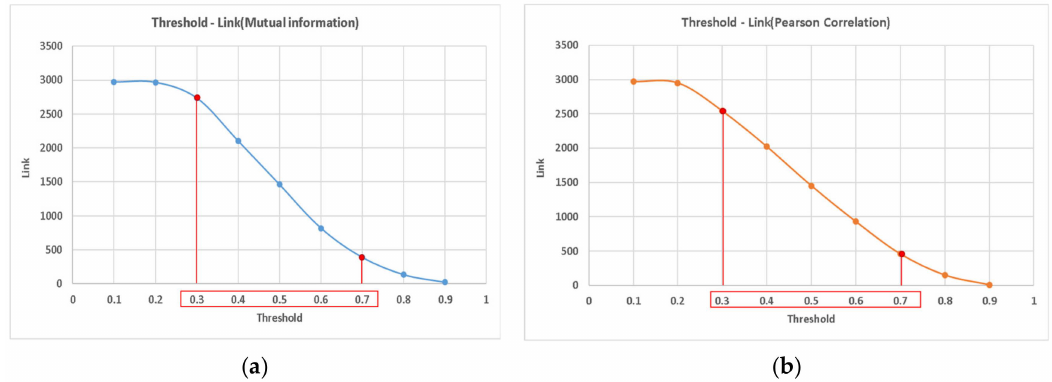
Figure 4. The number of links according to threshold: ( a ) mutual information; ( b ) Pearson